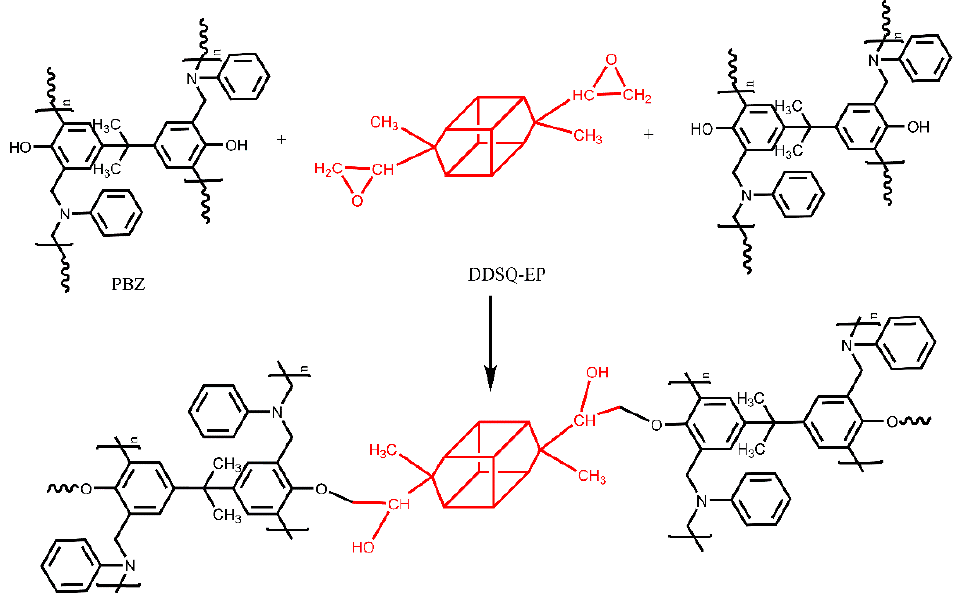
Figure 8. The crosslinking between PBZ and DDSQ-EP.